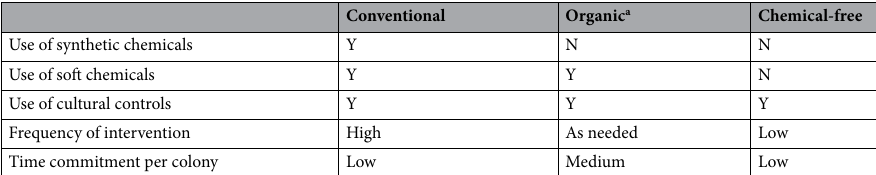
Table 1. Summary of differences among the three management systems based on beekeeping philosophy. This information is based on results from Underwood et al. 15 . Protocols for each management system developed for this experiment are congruent with these differences and were based on input from advisor beekeeper participants. a The term “organic” refers to the type of management that uses principles of integrated pest management (IPM) and limits in-hive products used for pest control to organic-approved 19,20 . However, the products of these colonies cannot be certified as organic by the USDA due to land-use restrictions 22